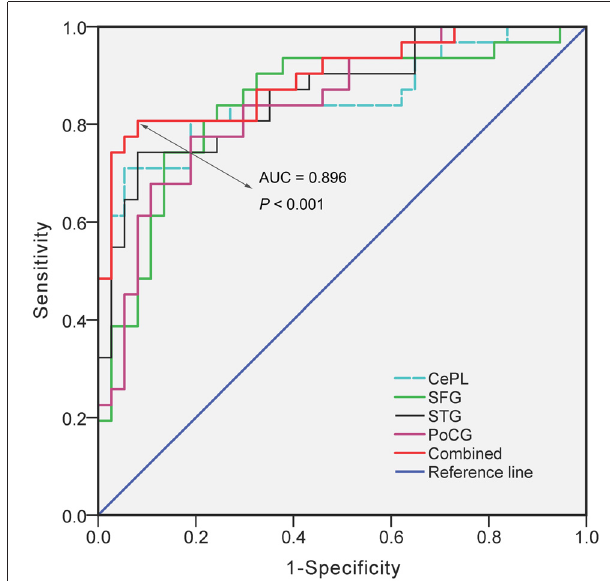
FIGURE 4 | The diagnostic performance of disrupted VMHC in differentiating LOD from HCs. Notes: VMHC, Voxel-Mirrored Homotopic Connectivity; LOD, Late-Onset Depression; HCs, Healthy Controls; CePL, Posterior Cerebellar Lobe; SFG, Superior Frontal Gyrus; STG, Superior Temporal Gyrus; PoCG, Postcentral gyrus; AUC, Area Under